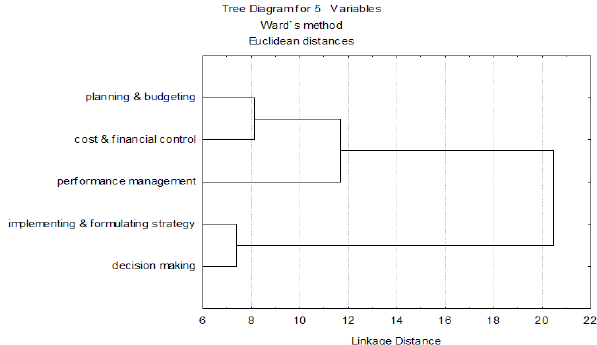
Fig. 1. The use of the information provided by the management accounting system for the performance of management activities in Poland.